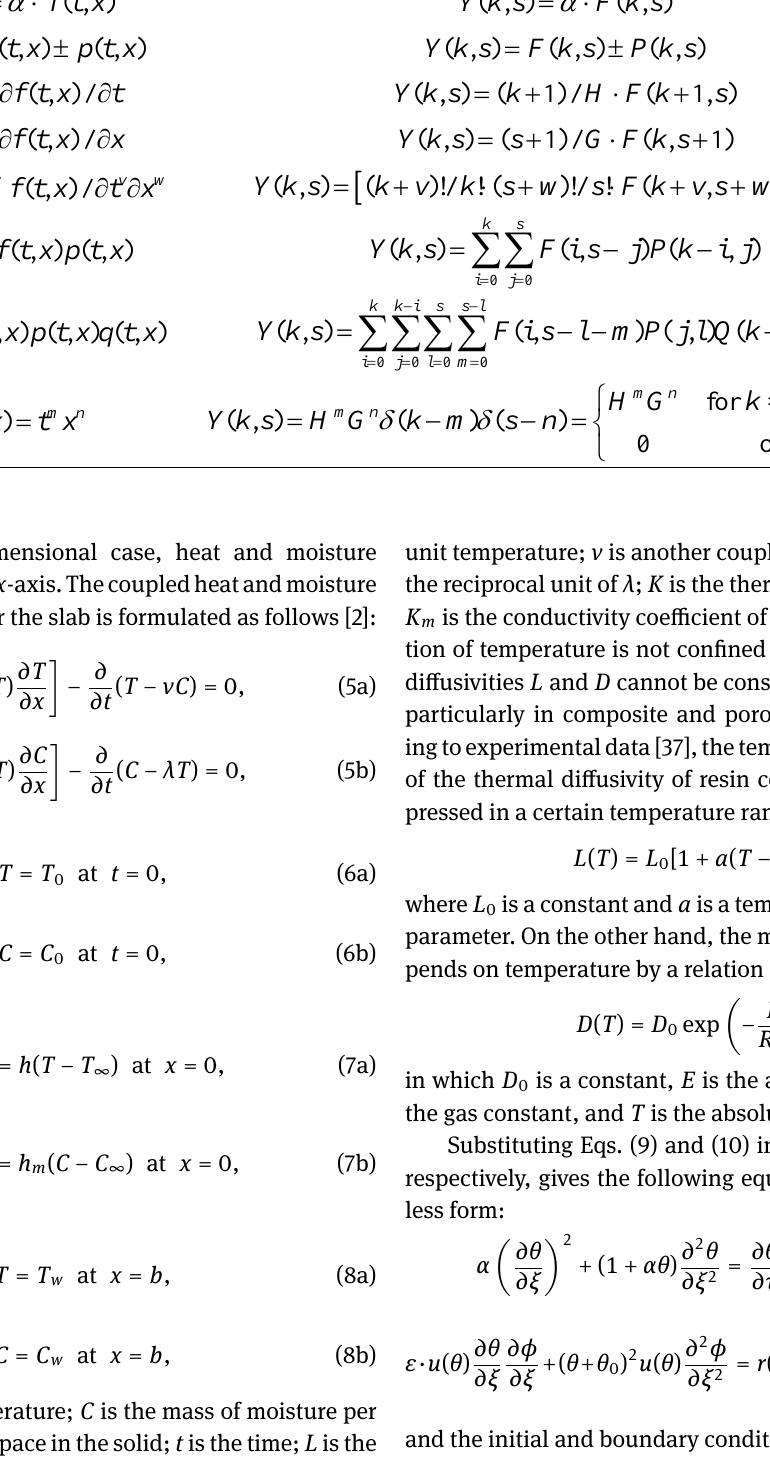
Original function y ( t , x